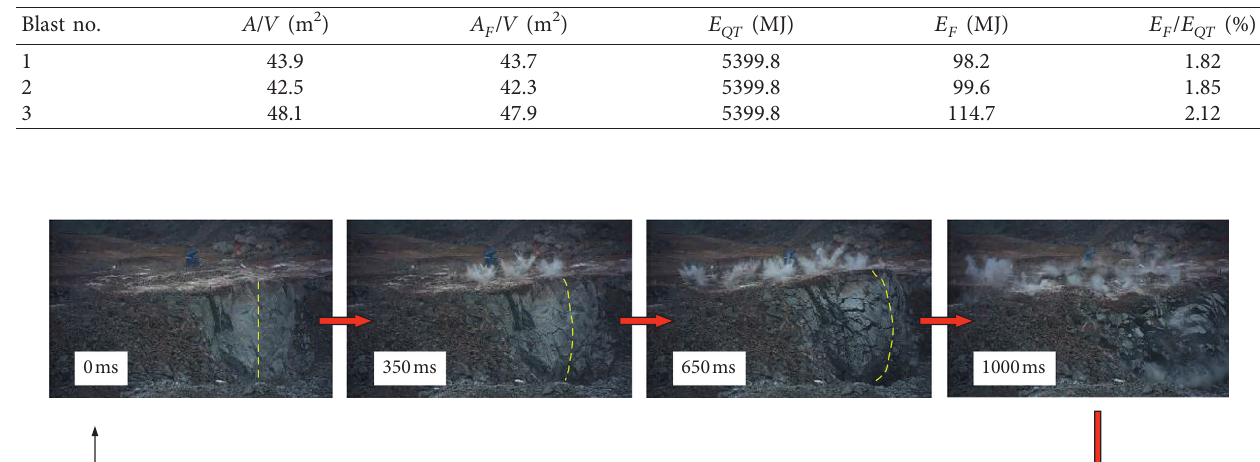
Table 6: Fragmentation energy in each blasting test.